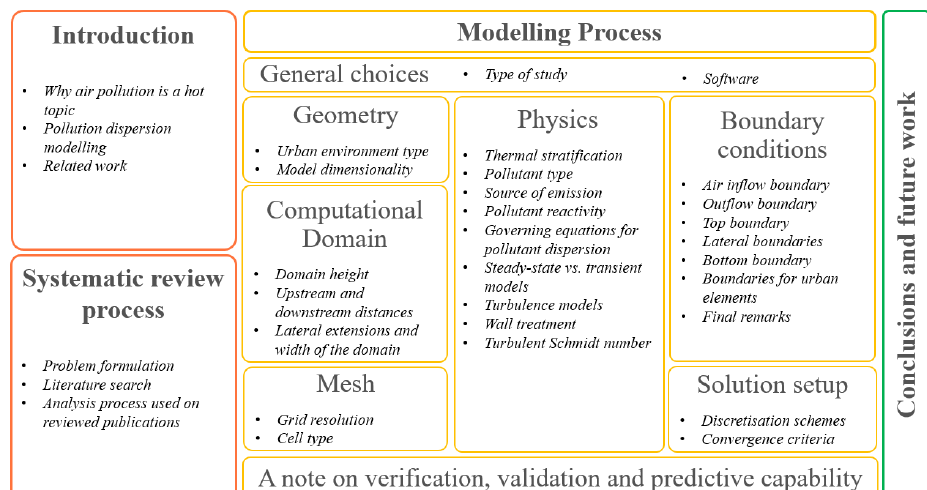
Figure 1. Structure of the